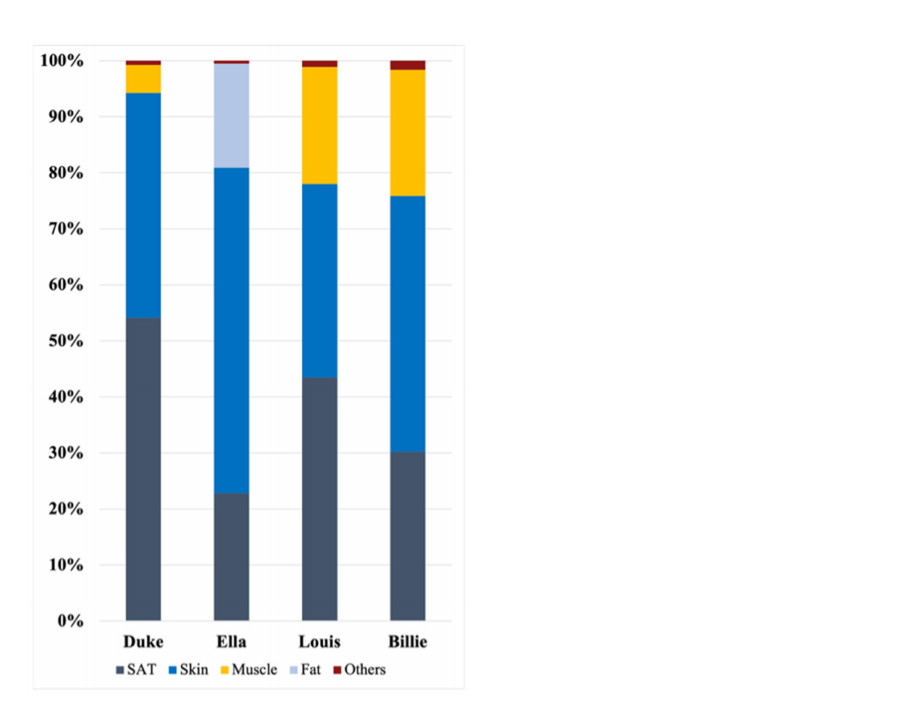
Figure 7. Percentages of tissues most involved in exposure in all studied configurations; the percent- ages are calculated with respect to the volume that the tissue occupies in the cubical sensor.